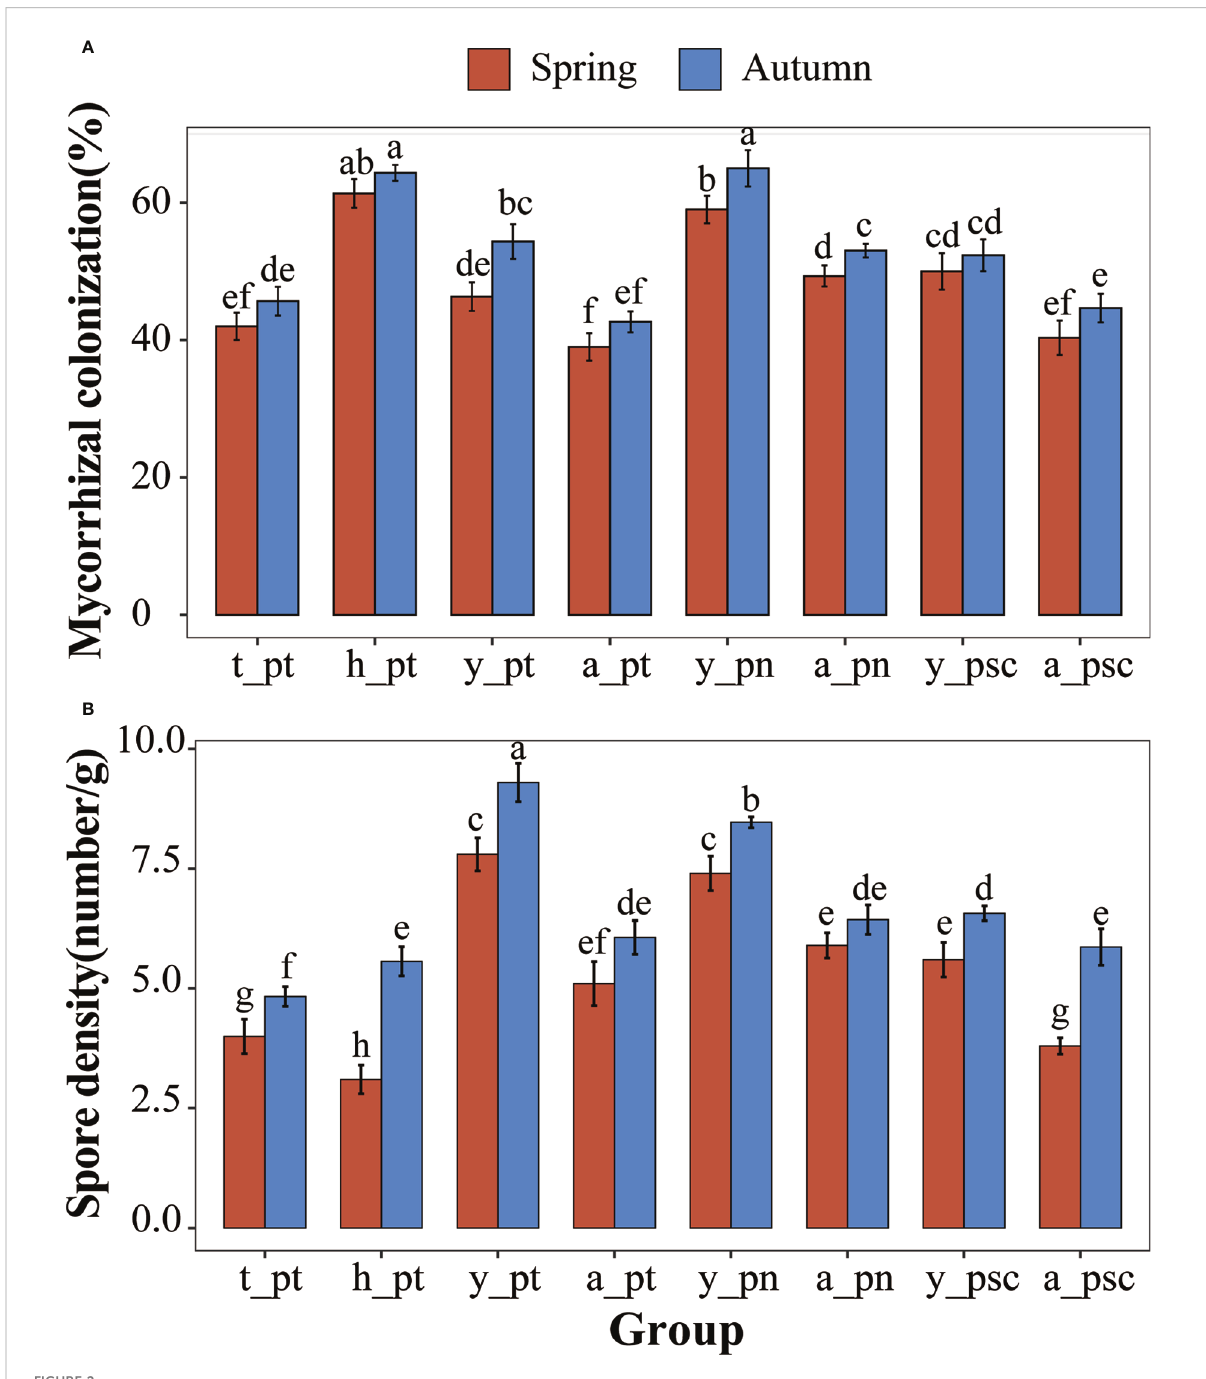
FIGURE 2 AMF colonization of poplars. (A) AMF colonization of poplar. (B) Spore density in rhizosphere soil of poplars. The lowercase letters y, a, t, and h, indicate young, adult, 30-year-old, and 100-year-old, respectively. Different letters on top of the bars indicate signi fi cant differences (p < 0.05). All data are presented as means ± standard